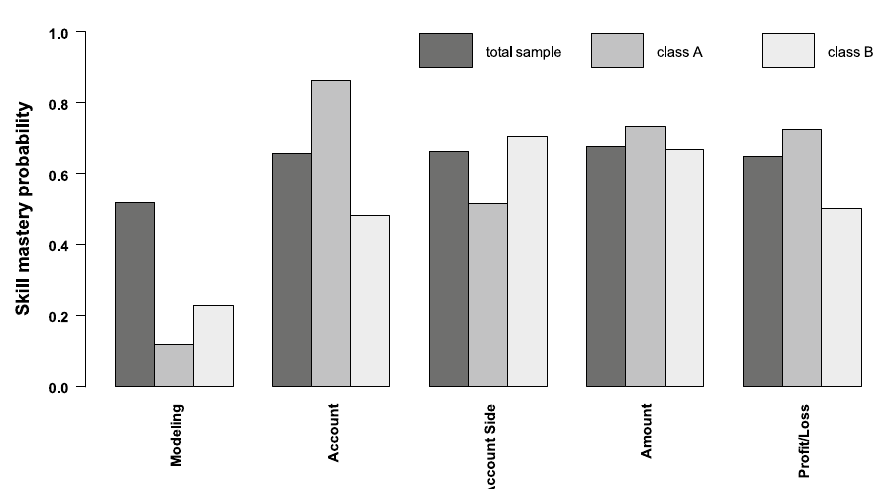
Fig. 4 Skill mastery in the entire sample and distinct school